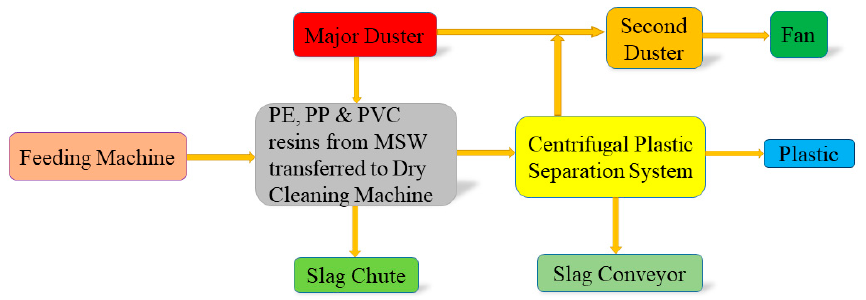
Figure 2. Preparation process flow chart of wood-plastic composites extracted from MSW.